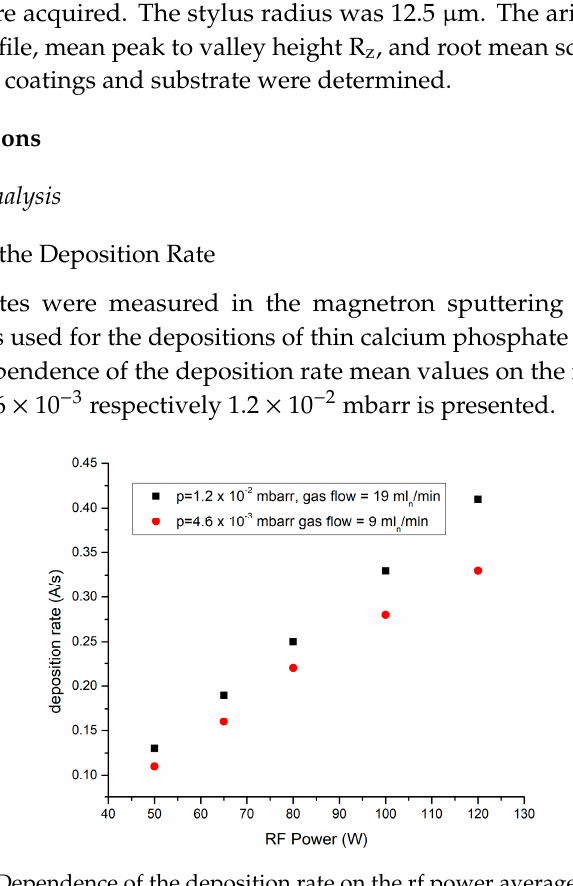
Figure 2. Dependence of the deposition rate on the rf power averaged on 600 s.